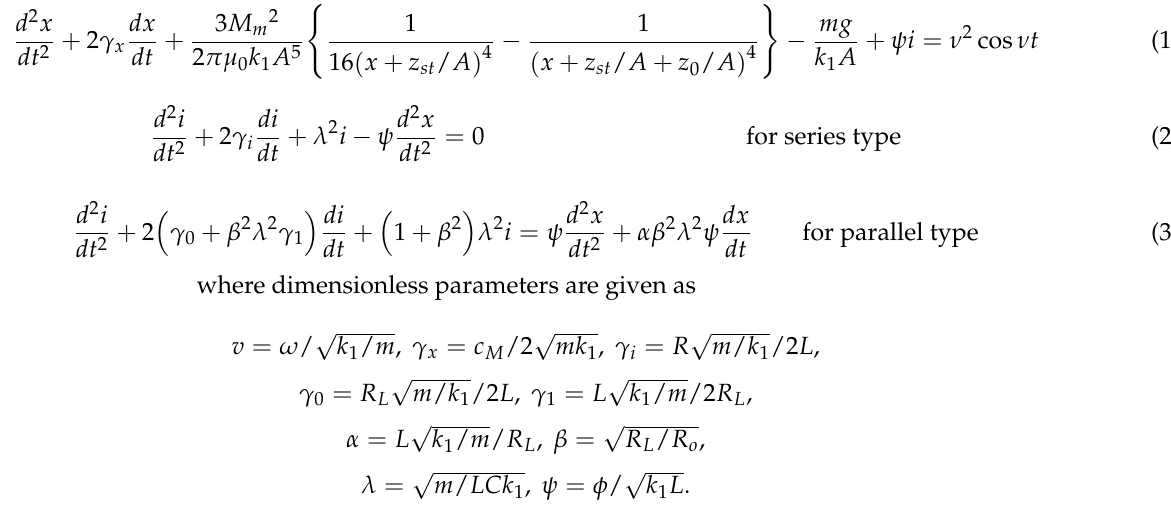
Figure 2. Two types of LCR shunt circuit. ( a ) series type; ( b ) parallel type.